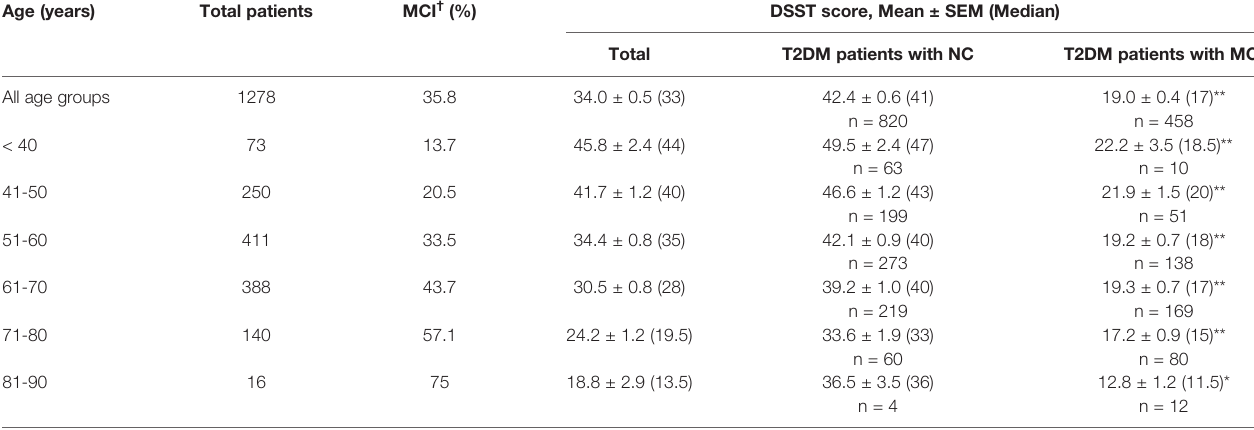
TABLE 1 | Age wise strati fi ed data of MCI and respective DSST scores in T2DM patients. Age (years) Total patients